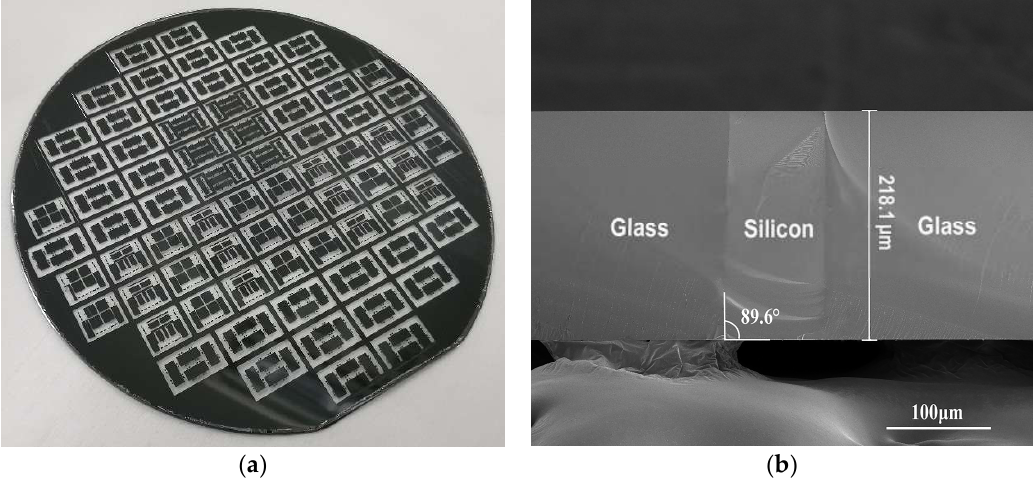
Figure 2. ( a ) Photograph for the glass-silicon composite substrate; ( b ) cross-sectional scanning electron microscopy (SEM) view of the silicon feedthrough after planarization.